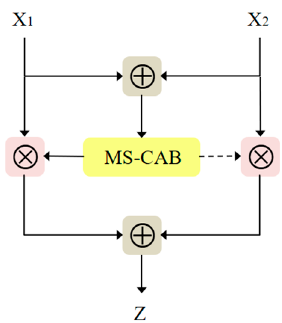
Figure 9. The AFFB structure .